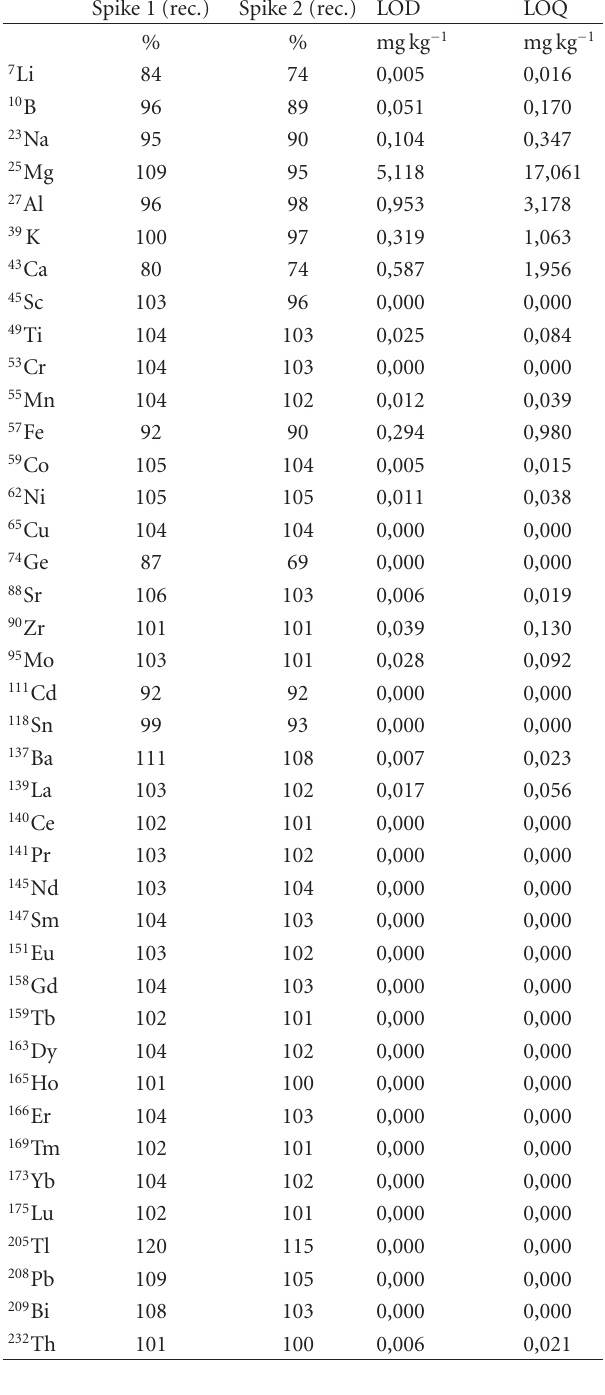
Table 3: Summing up of the analyses of the discriminating func- tions.